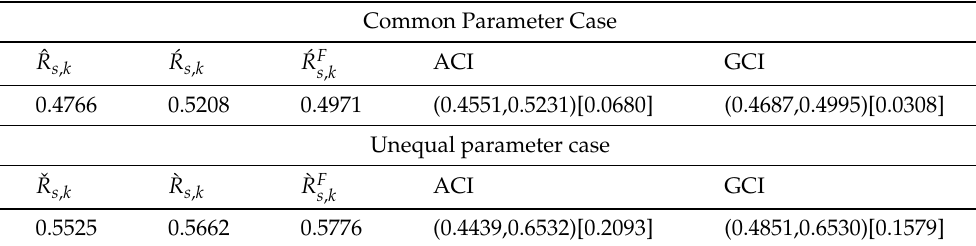
Table 5. Estimates of R s , k based on the real data